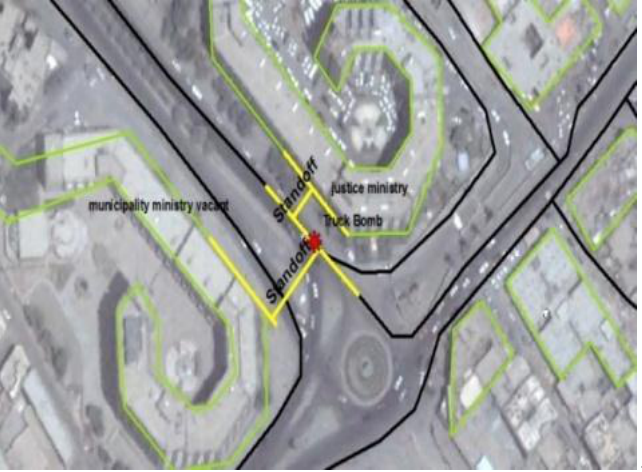
Fig.9: Illustration the standoff distance from truck bomb about 15m to main target side 1 (justice ministry) and 30m at second target side